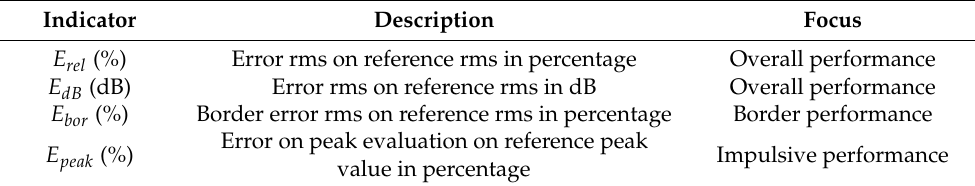
Table 3. Performance indicators